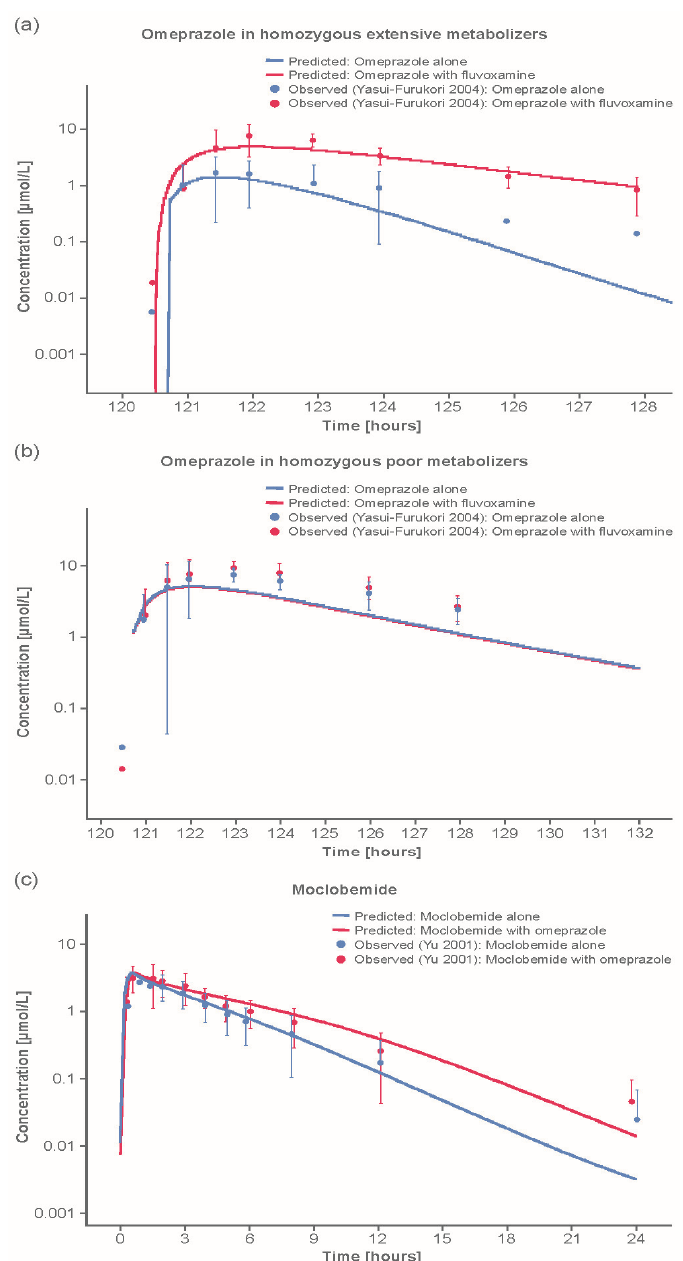
Figure 3. Example comparisons of model-predicted and observed CYP2C19 DDI outcomes: ( a ) observed and predicted omeprazole concentrations with and without fluvoxamine coadministration in homozygous extensive metabolizers; ( b ) observed and predicted omeprazole concentrations with and without fluvoxamine coadministration in homozygous poor metabolizers; and ( c ) simulated and observed concentration-time course for moclobemide with and without omeprazole coadministration. Additional comparisons of model-predicted vs. observed DDI outcomes can be found in Supplementary Material